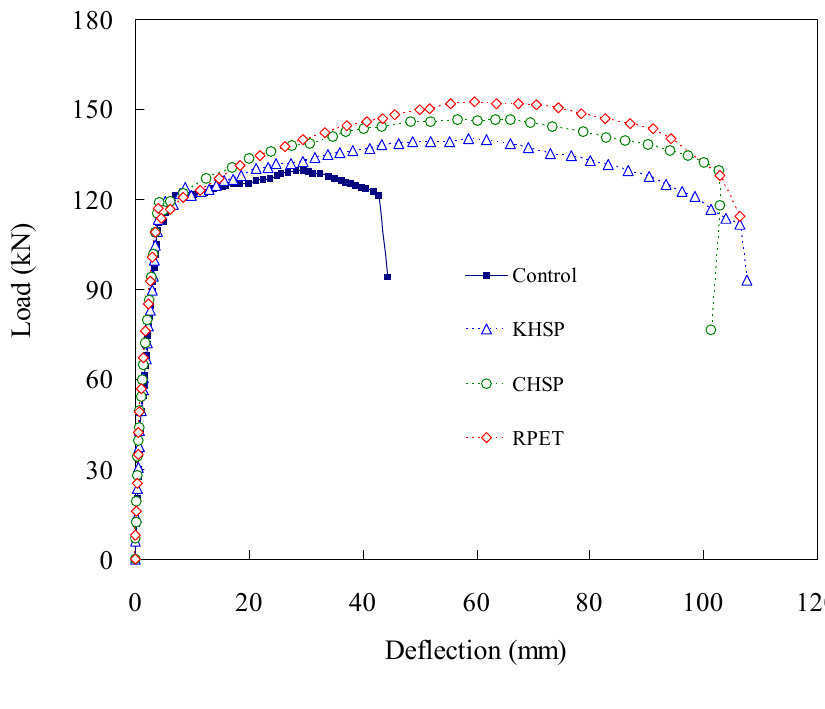
Figure 15. Load-deflection curves for recycled PET fiber RC